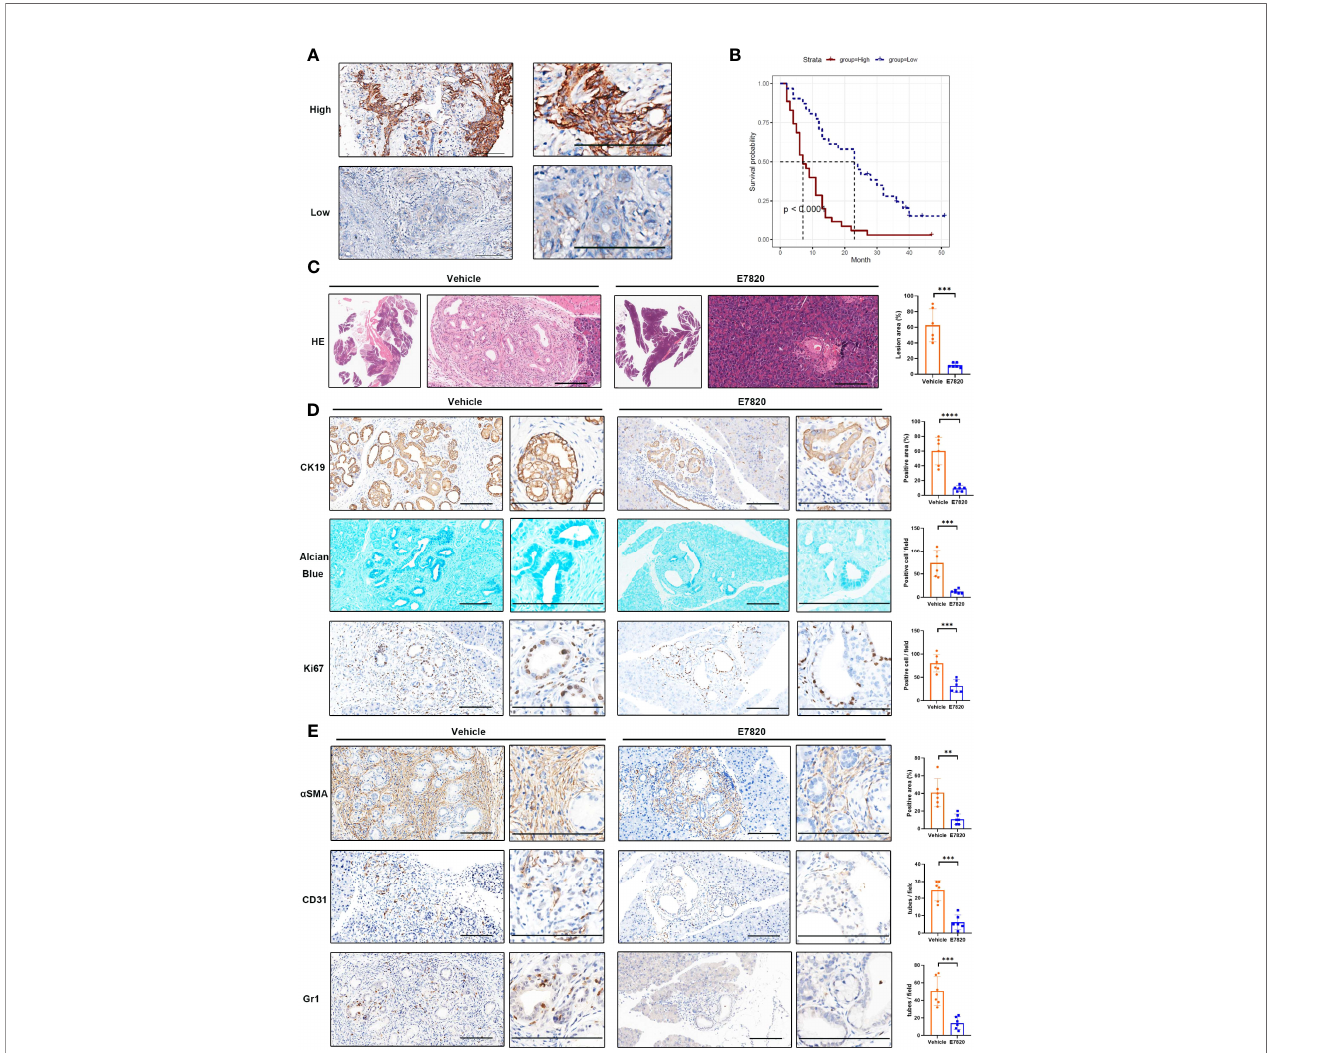
FIGURE 7 | Inhibition of ITGA2 prevents PDAC growth. (A) Immunohistochemical analyses of ITGA2 expression in PDAC samples. The representative images of high and low ITGA2 staining in PDAC specimens were shown. (B) Kaplan – Meier plots show the overall survival of PDAC patients expressing high and low levels of ITGA2 protein. (C – E) Pdx1-Cre + , Kras G12D ( KC ) mice were orally treated with E7820 (100 mg/kg bodyweight) once a day, for 14 consecutive days. (C) The H&E staining of mice pancreatic lesions. The percentage of the lesion area was statistically compared between vehicle and E7820 treatment groups, t test, ***P < 0.001, n=6 fi elds. (D) Alcian blue staining of pancreas tissues. The representative images and statistically analysis results of CK19 and Ki67 immunohistochemical staining slides, t test, ***P < 0.001, ****P < 0.0001, n=6 fi elds. (E) Immunohistochemistry analyses of pancreas tissues from vehicle and E7820-treated KC mice by anti- a SMA, anti-CD31, and anti-Gr1 antibodies, t test, **P < 0.01, ***P < 0.001, n=6 fi elds. Bar=200 m